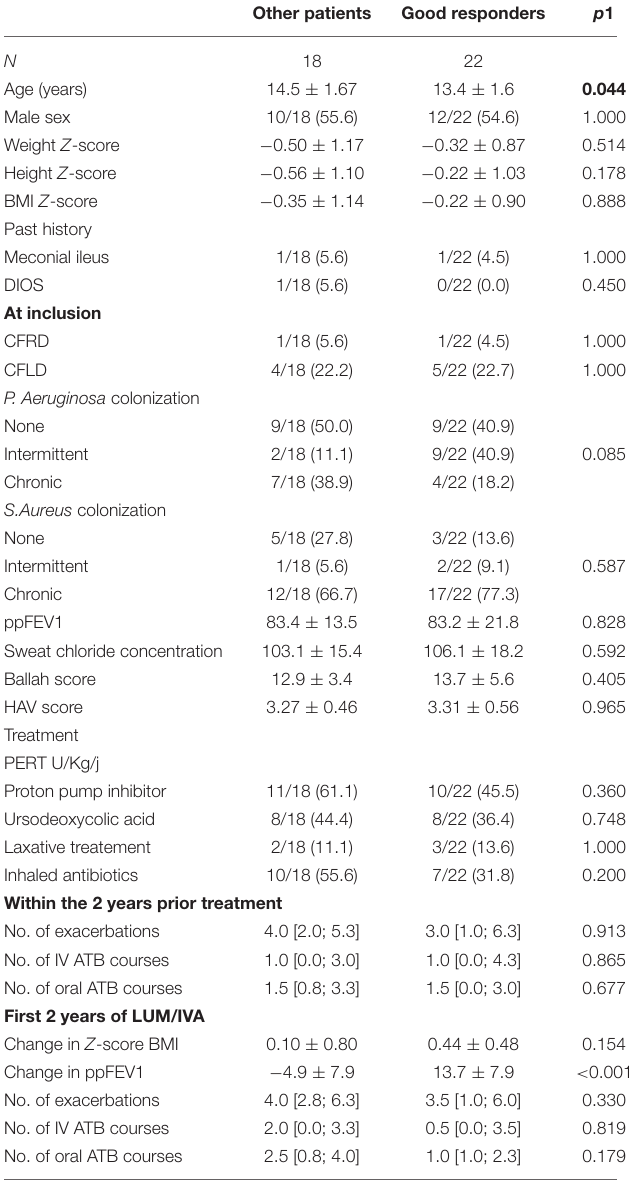
TABLE 2 | Patient characteristics at initiation of lumacaftor/ivacaftor. Other